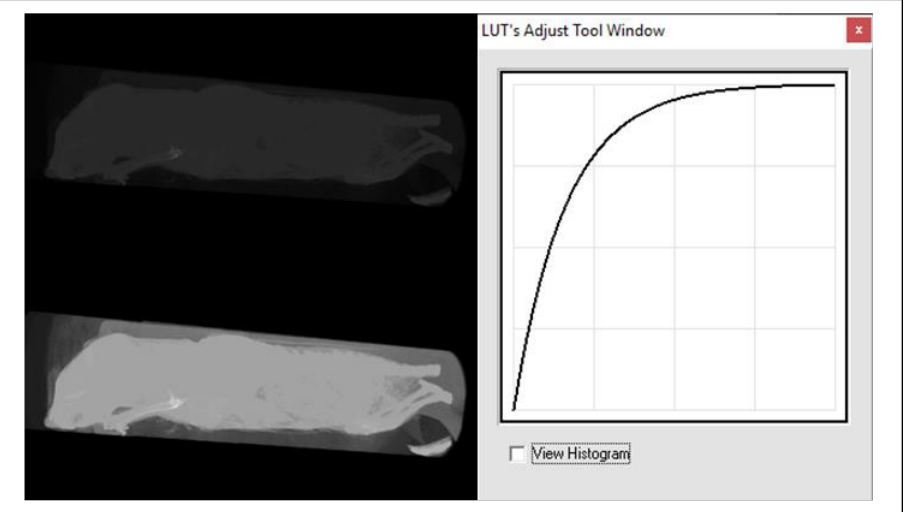
Figure 7. Examples of point operator (function) — logarithmic function [16].